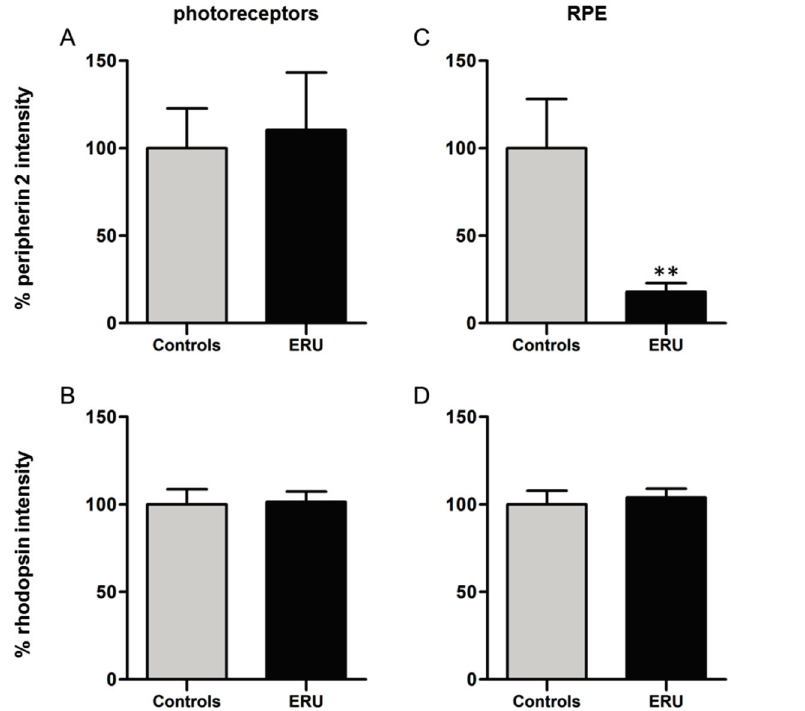
Figure 3. ( A ) Quantification of the fluorescence intensity of peripherin 2 expression in photoreceptor outer segments revealed no significant difference between healthy (grey column) and ERU cases (black column); ( B ) There was also no significant difference between the fluorescence intensity of rhodopsin in photoreceptor outer segments of healthy (grey column) and uveitic (black column) retinas detectable; ( C ) A significant reduction of the fluorescence intensity of peripherin 2 in uveitic RPE to 17.9% (black column), compared to RPE of negative controls (** p ≤ 0.01); ( D ) Quantification of the fluorescence intensity of rhodopsin in RPE showed no significant difference between healthy (grey column) and ERU cases (black